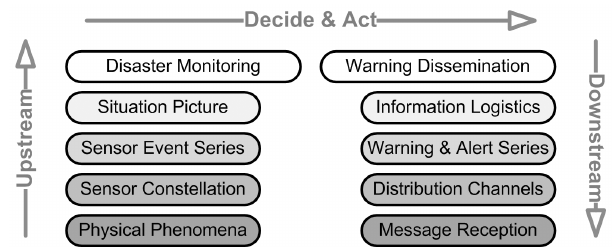
Fig. 1. Upstream and downstream flow of events and information in early warning systems (W¨achter et al., 2009; Lendholt and Ham- mitzsch,